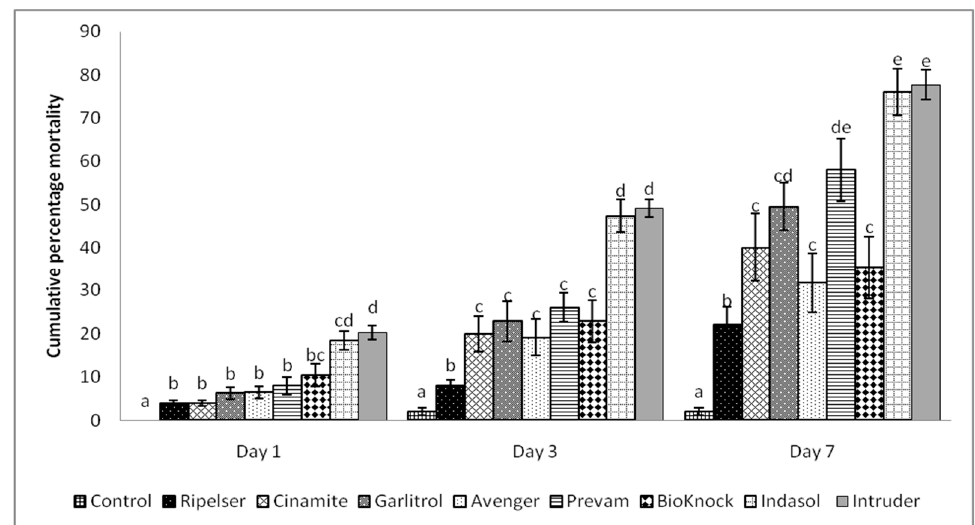
Figure 3. Contact toxicity of products on 2nd instar larvae of C. chalcites . Different letters above bars indicate a significant difference among the groups according to ANOVA followed by Tukey’s HSD test ( p < 0.05).